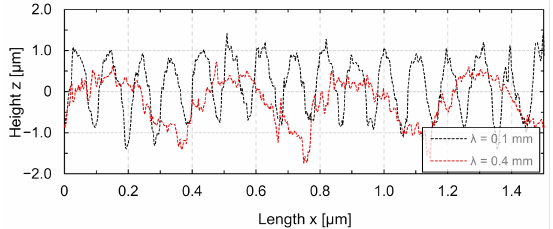
Figure 8. Representative longitudinal sections along the middle of the remelted tracks for λ = 0.1 mm and λ = 0.4 mm ( d L = µ m, v scan = 200 mm s − 1 , P M = 12.2 W, P A = 4.6